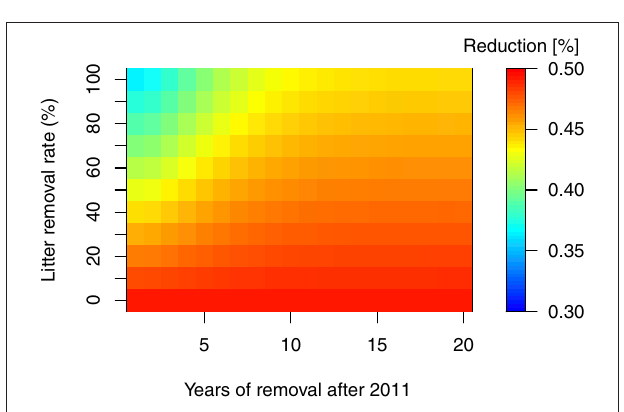
FIGURE 6 | Reduction rate in percent total 137 Cs inventory, 30 years after the fallout event, for litter removal at various rates and timing.